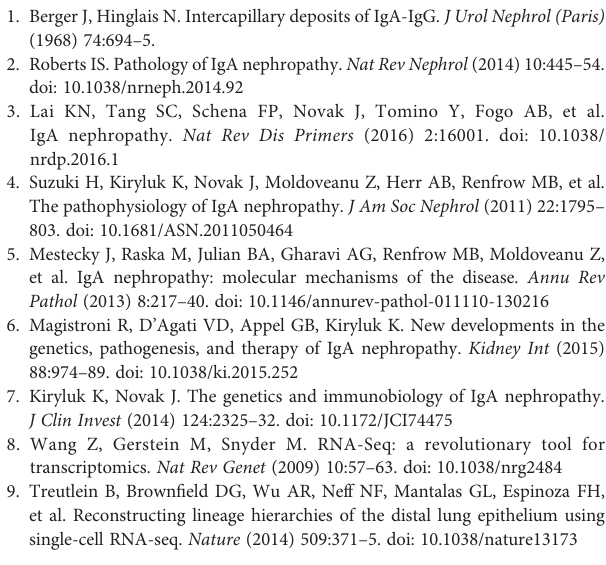
Supplemental Table 2 | Number and viability of cells in kidney from each